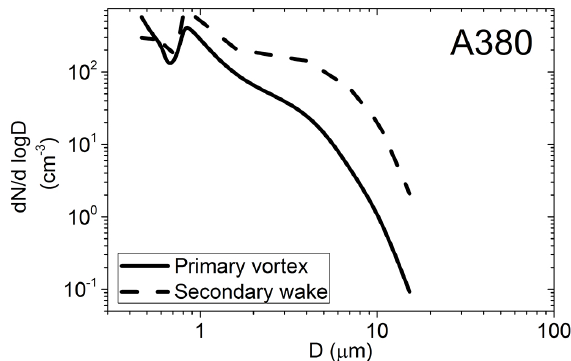
Fig. 8. Particle size distribution observed in the contrail of the A380 aircraft. The secondary wake has been observed between 44182s and 44232s UTC (see Fig. 2) at a contrail age of ≈ 105s; the pri- mary vortex was also observed between 44112s and 44158s UTC at a contrail age of ≈ 92s on 19 November 2008. Particle concen- trations decrease in the primary vortex due to partial particle subli- mation of initially larger ice